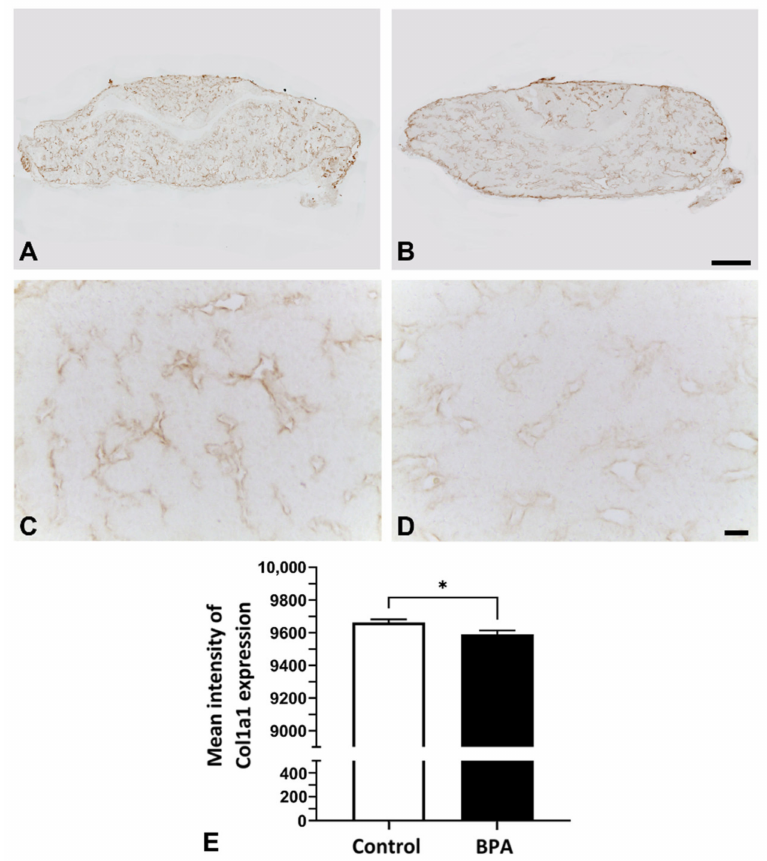
Figure 5. Immunohistochemistry of collagen Type I on postnatal Day 1 in the anterior pituitary glands of control rats (( A , C ): higher magnification view of ( A )) and BPA-treated rats (( B , D ): higher magnification view of ( B )). Mean intensity in the control and BPA-treated groups ( E ). Note: * p < 0.05. Scale bars: 100 µ m ( A , B ); 10 µ m ( C , D